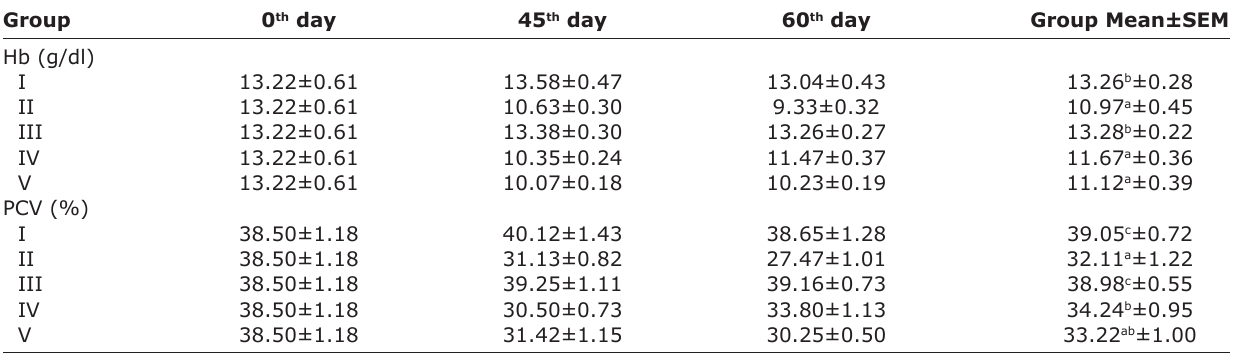
Table-1: Protective and ameliorative effects of SLE supplementation on hematological parameters in lead intoxicated rats. Group